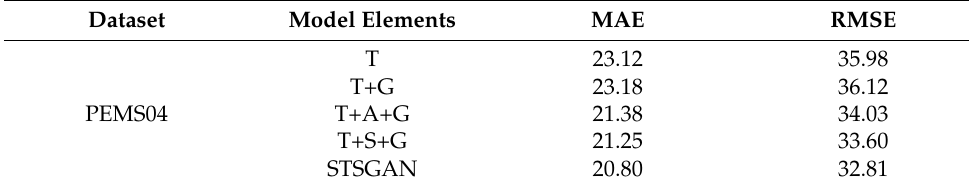
Table 2. Performance comparison of T-GACN and its variants in traffic flow